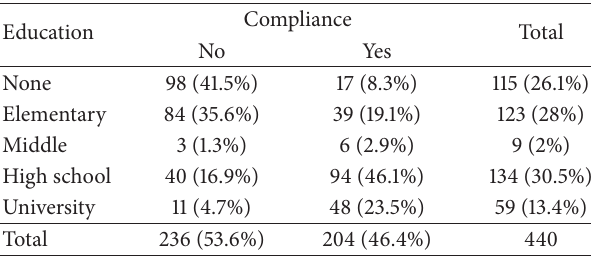
Table 2: Effect of formal education level on compliance to antiglau- coma medication.